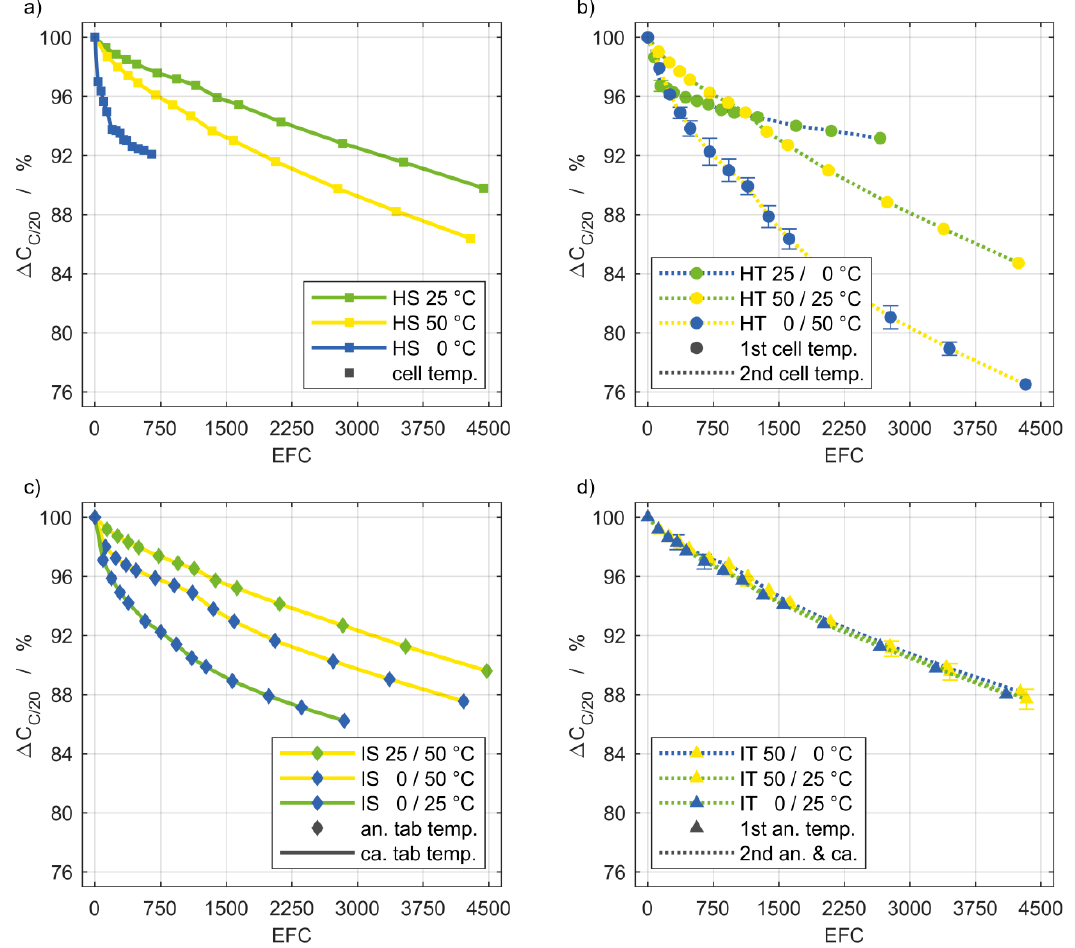
Figure 3. Discharge capacity fade of the setups ( a - d ) shown in Figure 1. The markers indicate the averaged values obtained by the intermediate cell characterizations and their color represents the anode tab temperature of inhomogeneous setups ( c , d ). The color of the lines represents the cathode tab temperature of inhomogeneous setups as well as the second temperatures for transient boundary conditions that cycle between their 1st and 2nd temperature level ( b ). Based on the initial values in Table 1, a capacity fade of 4% corresponds to a loss of approximately 121 mAh.